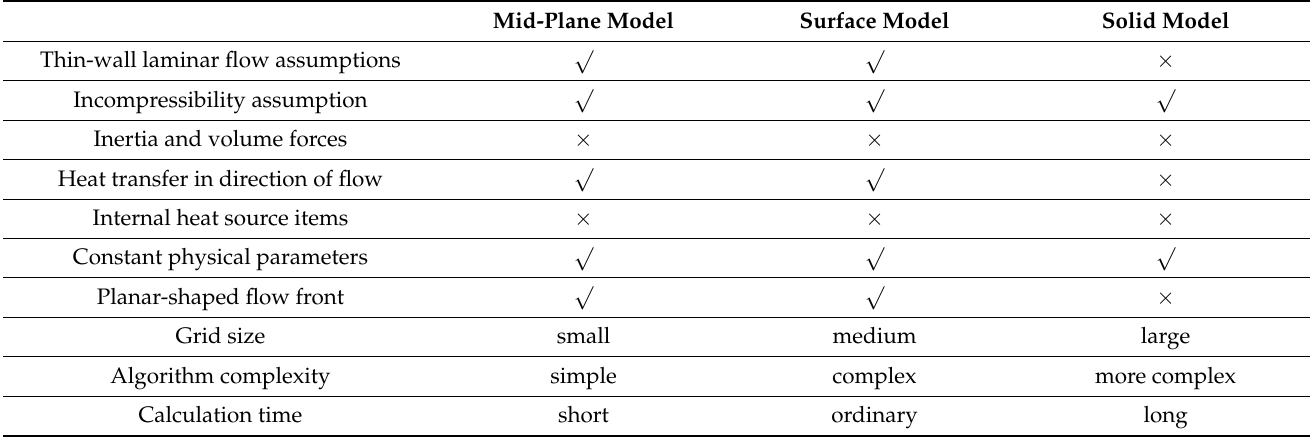
Table 2. Differences among three